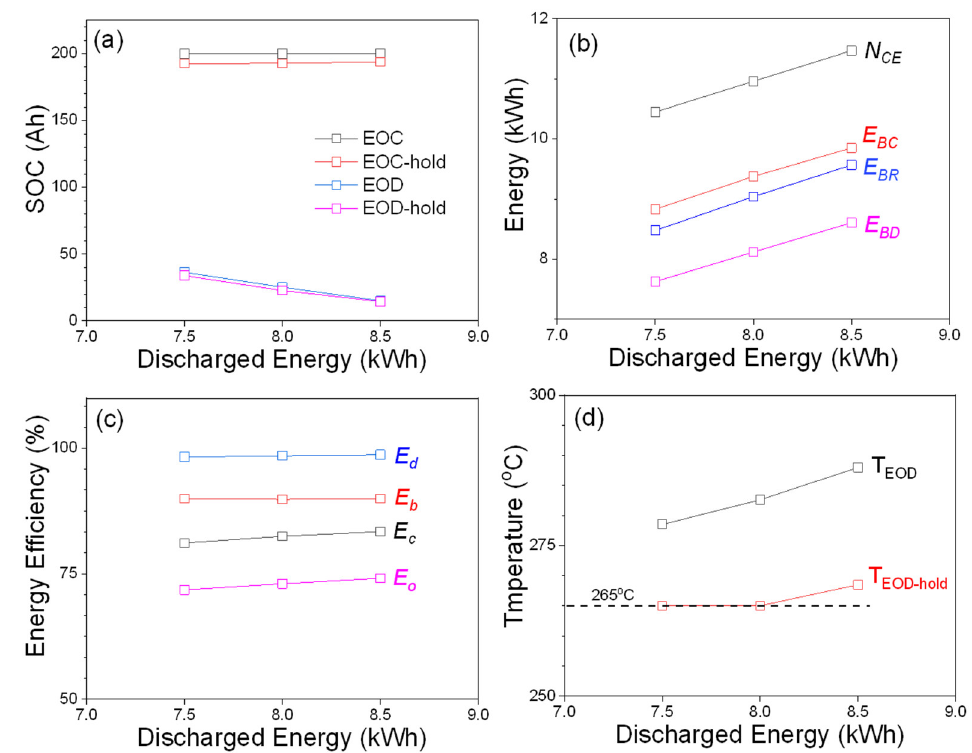
Figure 3. Module performances for peak-shaving tests with three different discharged energies: 7.5, 8.0, and 8.5 kWh. ( a ) SOC; ( b ) energy; ( c ) energy efficiency; ( d ) temperature of the module at EOD and EOD-hold.